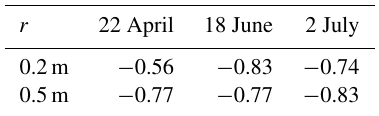
Table 3. Correlation coefficients ( r ) between measurements of soil water content at 0.2 and 0.5m depth, and the surface-air temperature